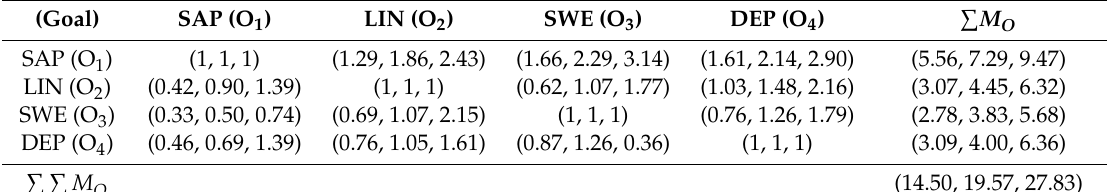
Table 5. The fuzzy evaluation (average value) with respect to the